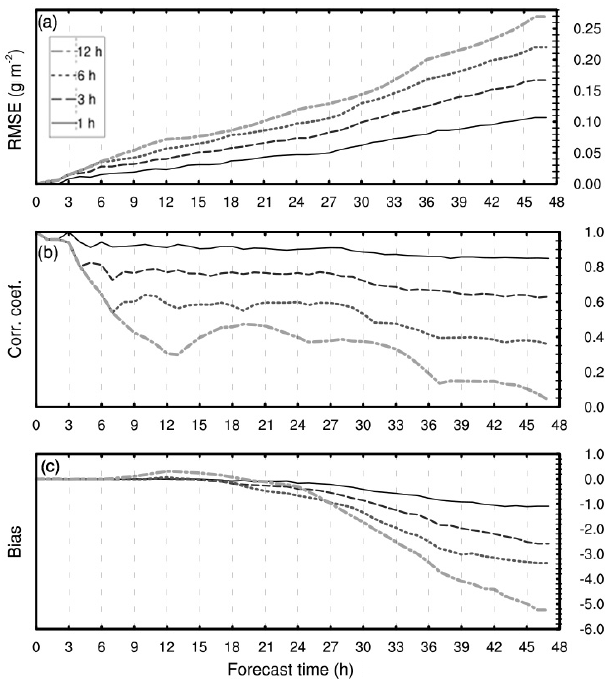
Figure 2. Quantitative evaluation scores for NMMB-MONARCH- ASH synthetic application: (a) root mean square error; (b) Pearson’s correlation coefficient; (c) error